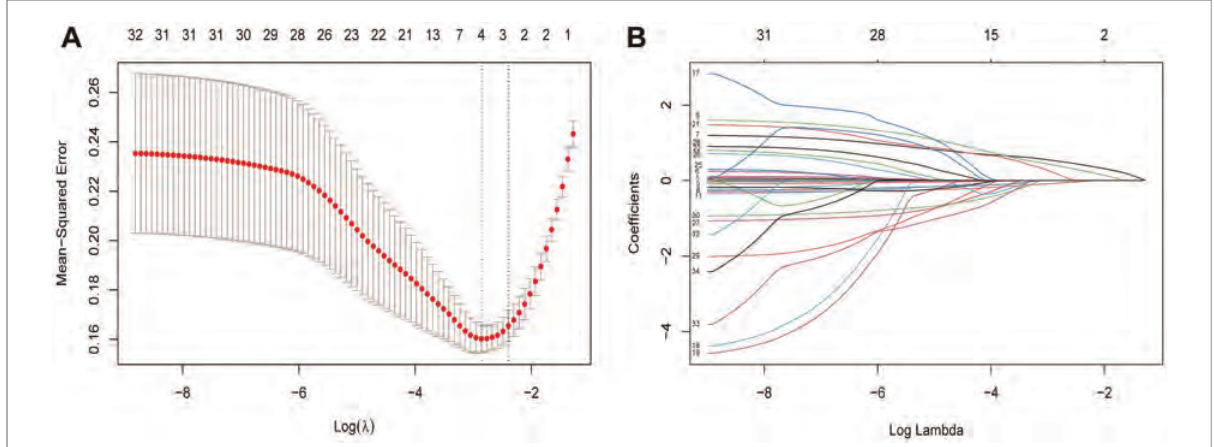
FIGURE 4 Demographic and clinical features selection using the LASSO regression model. Notes: ( A ) Optimal parameter (lambda) selection in the LASSO model used fi vefold cross-validation via minimum criteria. The partial likelihood deviance (binomial deviance) curve was plotted vs. log(lambda). Dotted vertical lines were drawn at the optimal values by using the minimum criteria and the 1 SE of the minimum criteria (the 1-SE criteria). ( B ) LASSO coef fi cient pro fi les of the 34 features. A coef fi cient pro fi le plot was produced against the log(lambda) sequence. Vertical line was drawn at the value selected using fi vefold cross-validation, where optimal lambda resulted in fi ve features with nonzero coef fi cients. LASSO, least absolute shrinkage and selection operator; SE, standard error.